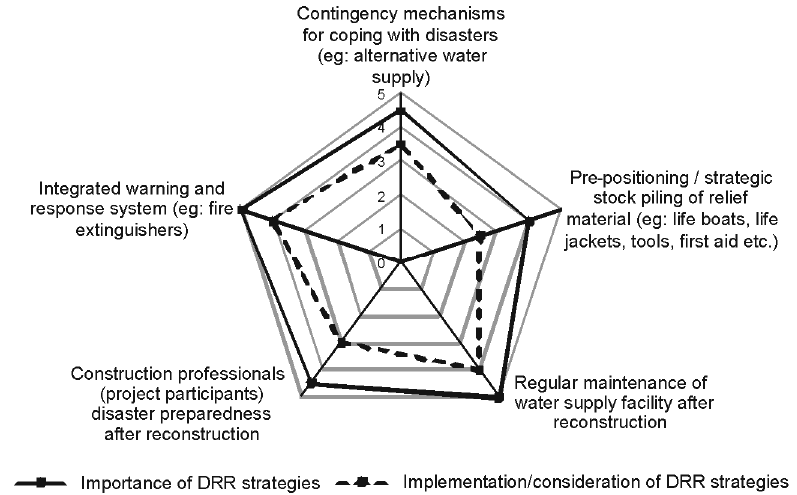
Fig. 2. Comparison of importance of emergency preparedness strategies and their level of